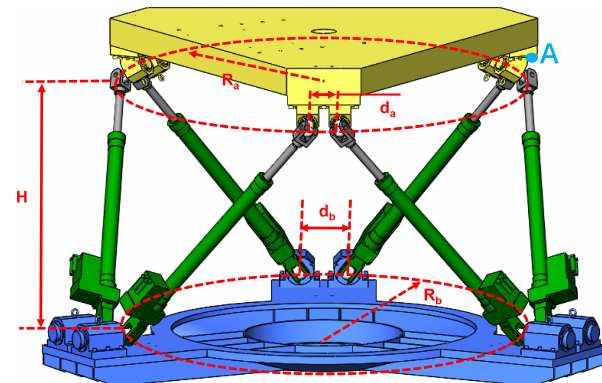
Figure 5. Structure